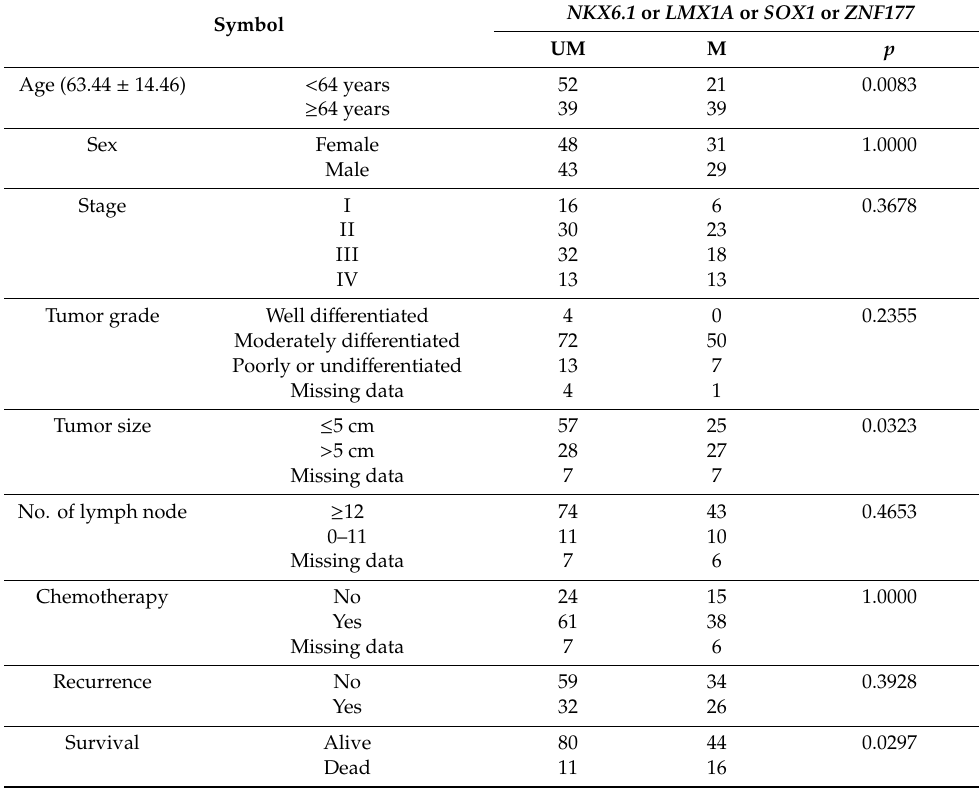
Table 3. The associations between the four-gene methylation panel and clinicopathological characteristics in 151 CRC patients.